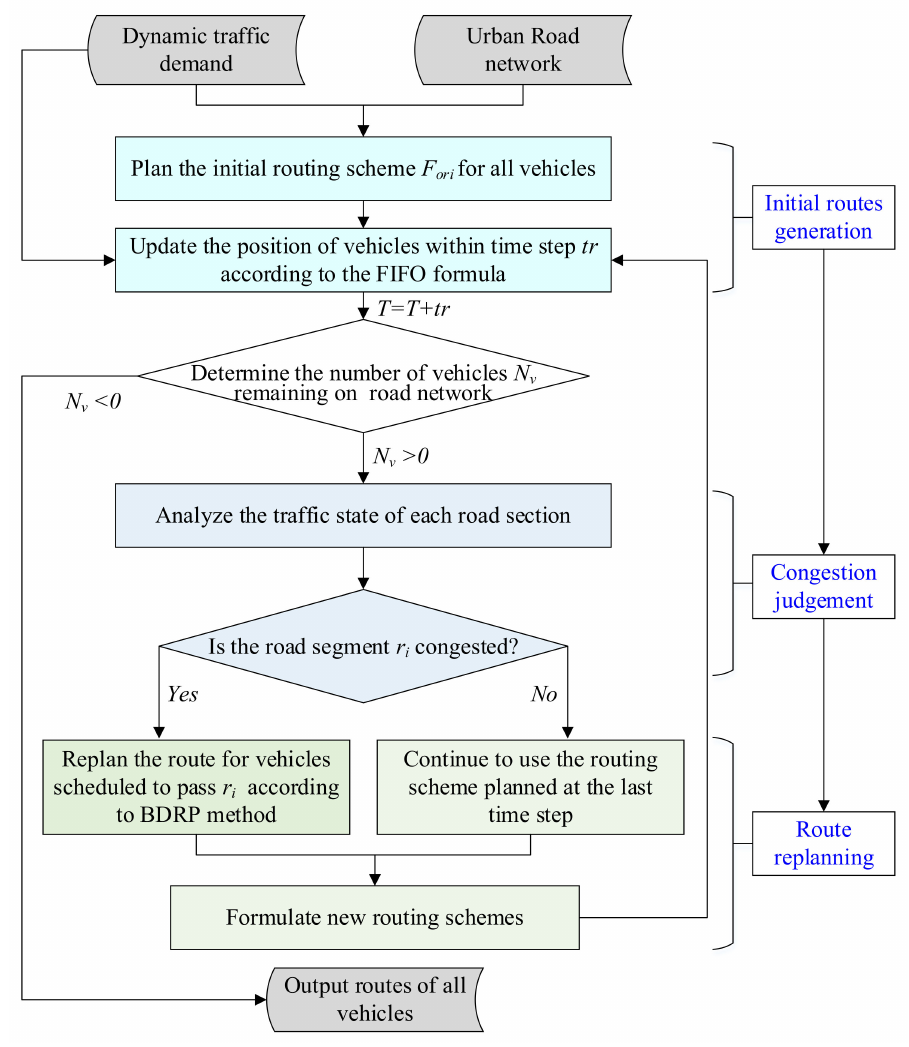
Figure 1. Dynamic route-planning flow.